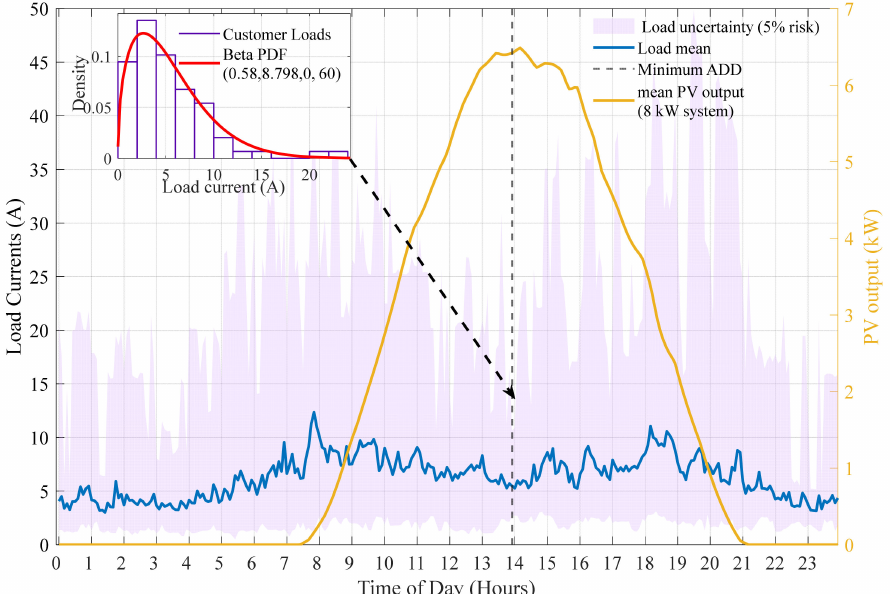
Figure 3. Representation of the load demand for a typical summer day for a group of